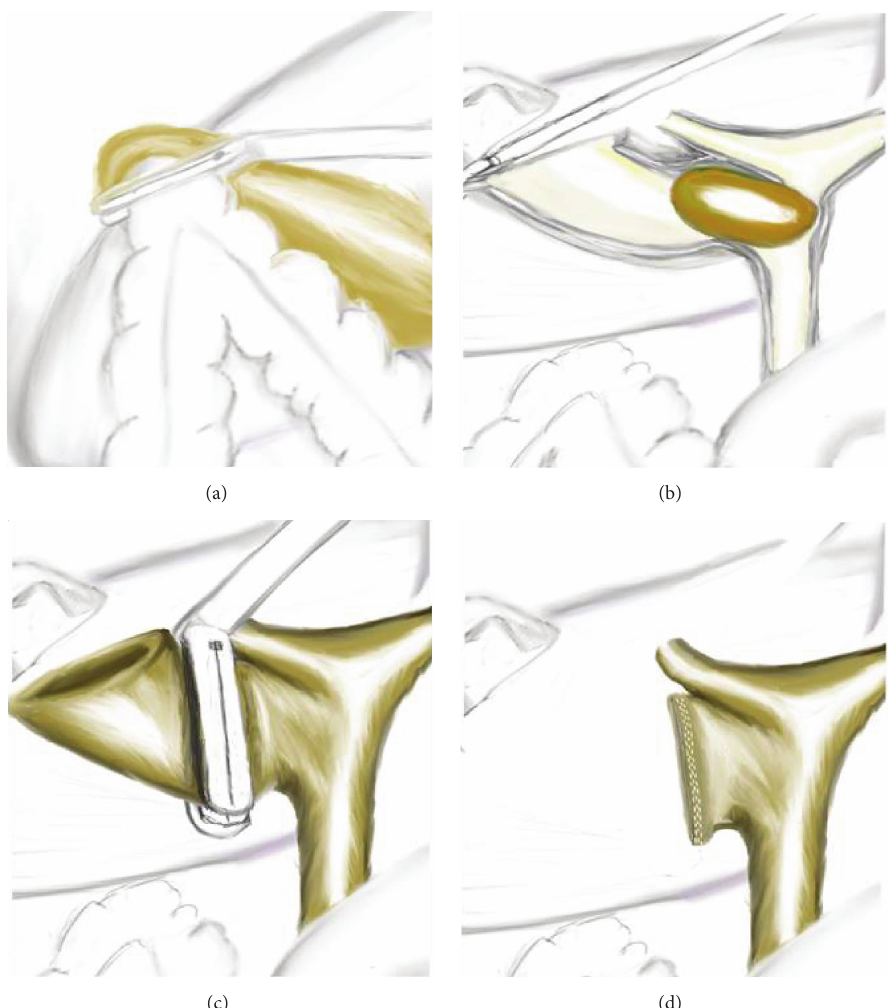
Figure 5: Schematic illustration of the case: (a) illustration is seen during the resection of cholecystocolic fistula by Tri-Staple. (b) Impacted stone is seen in the cholecystocholedochal fistula like type IV Mirizzi syndrome, illustration is drown as anterior surface of gallbladder and biliary was opened. (c) Subtotal cholecystectomy line by Tri-Staple is seen. (d) After completion of the subtotal cholecystectomy, stump of gallbladder and staple line on stump is